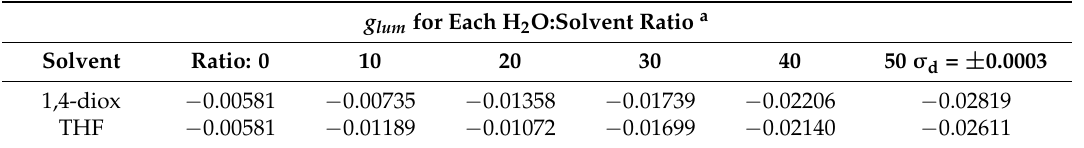
Table 4. Luminescence dissymmetry ratio values ( g lum ) for varying ratios of H 2 O:THF and 1,4-dioxane. g lum for Each H 2 O:Solvent Ratio